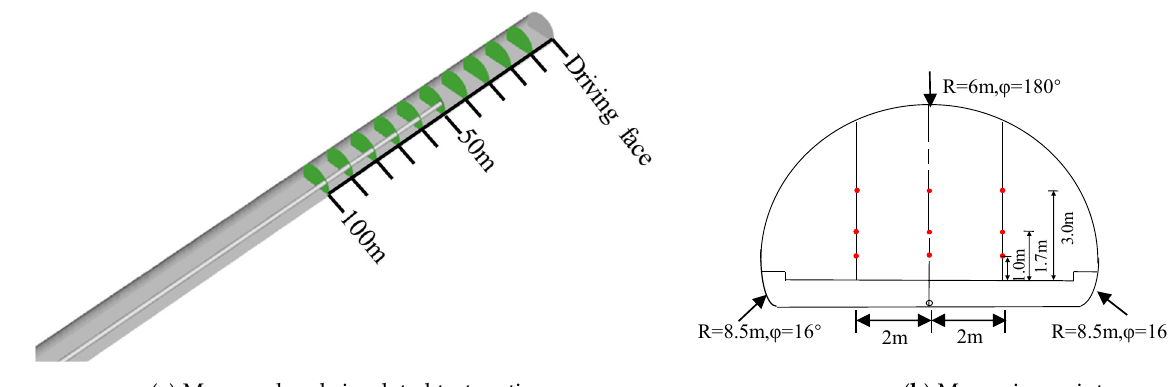
Figure 8. Test section layout.